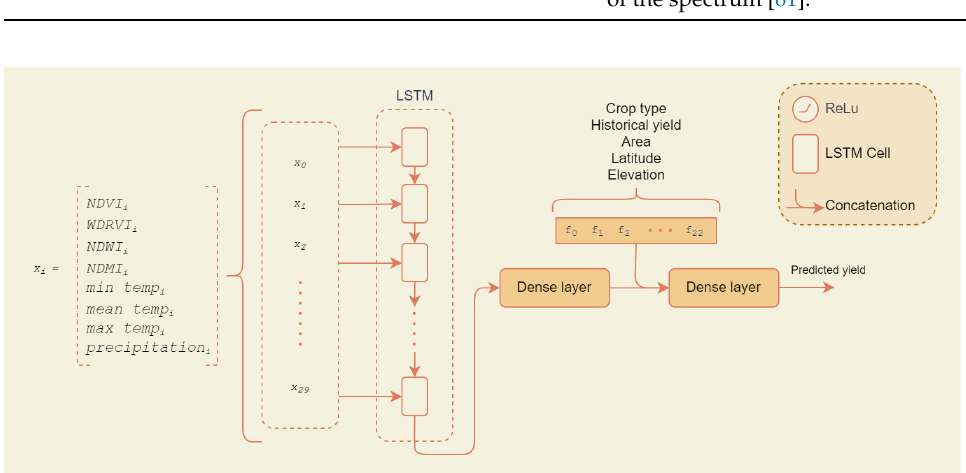
Figure 6. Initial experiment: architecture of LSTM model Using handcrafted